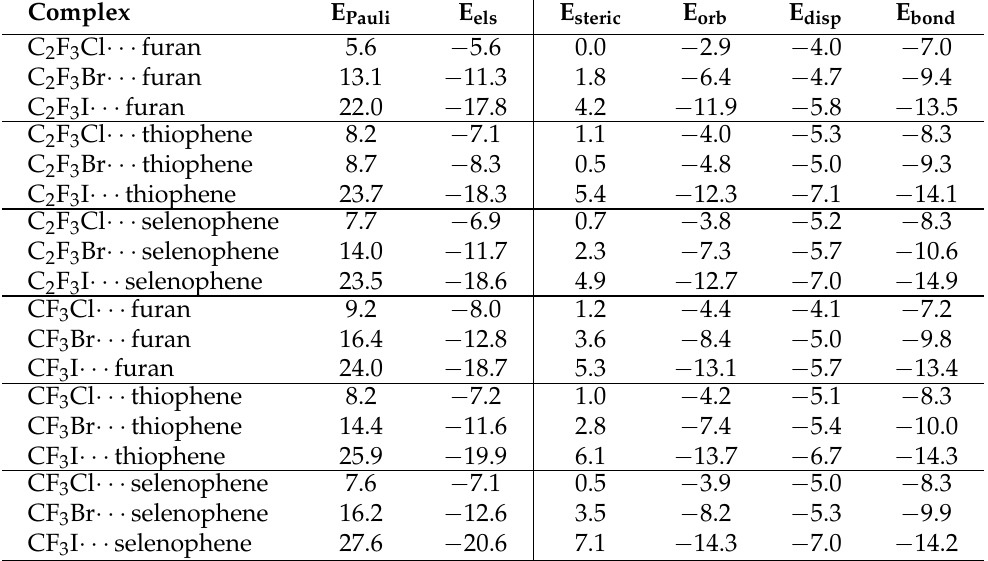
Table 5. Energy decomposition analysis (EDA) in kJ/mol for the perpendicular oriented